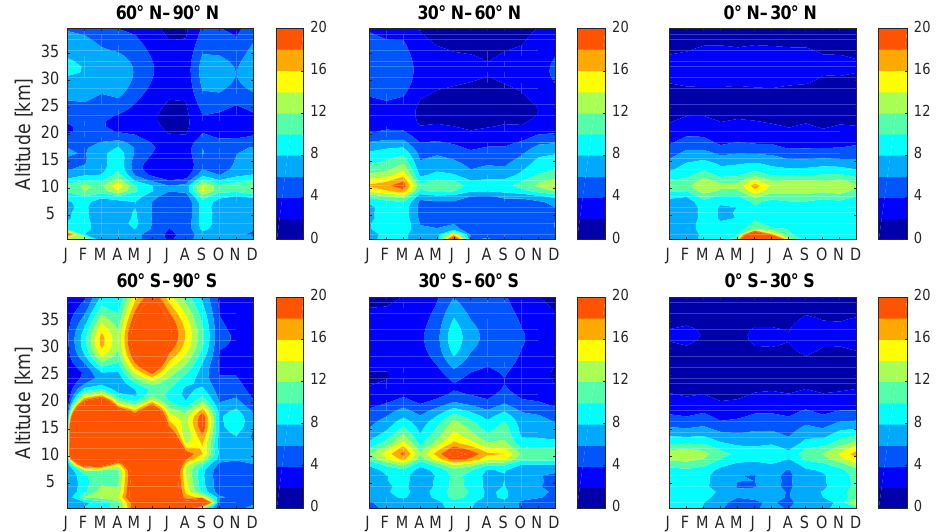
Figure 5. Contour representation of the standard deviation of the differences shown in Fig. 4 (in percent) as a function of altitude and time for the year 2014 for daytime